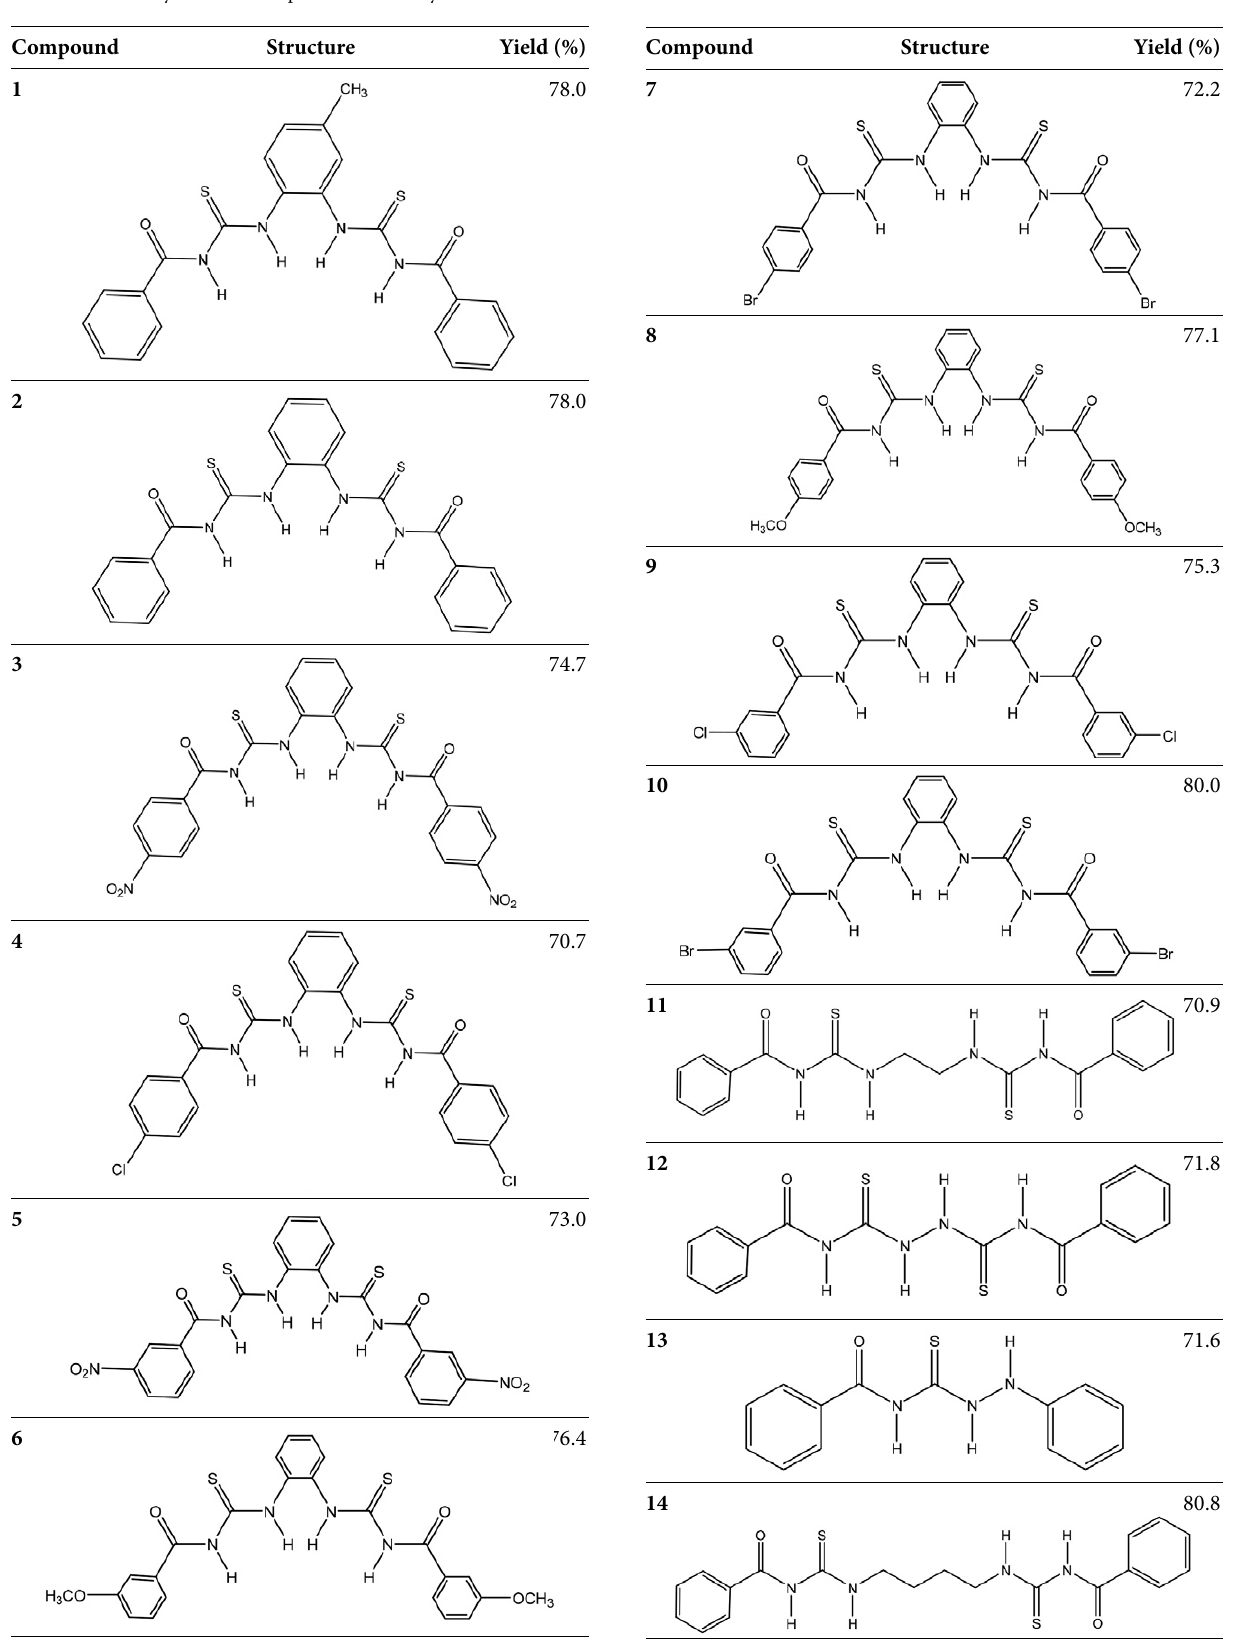
Table 1. List of synthesized compounds and their